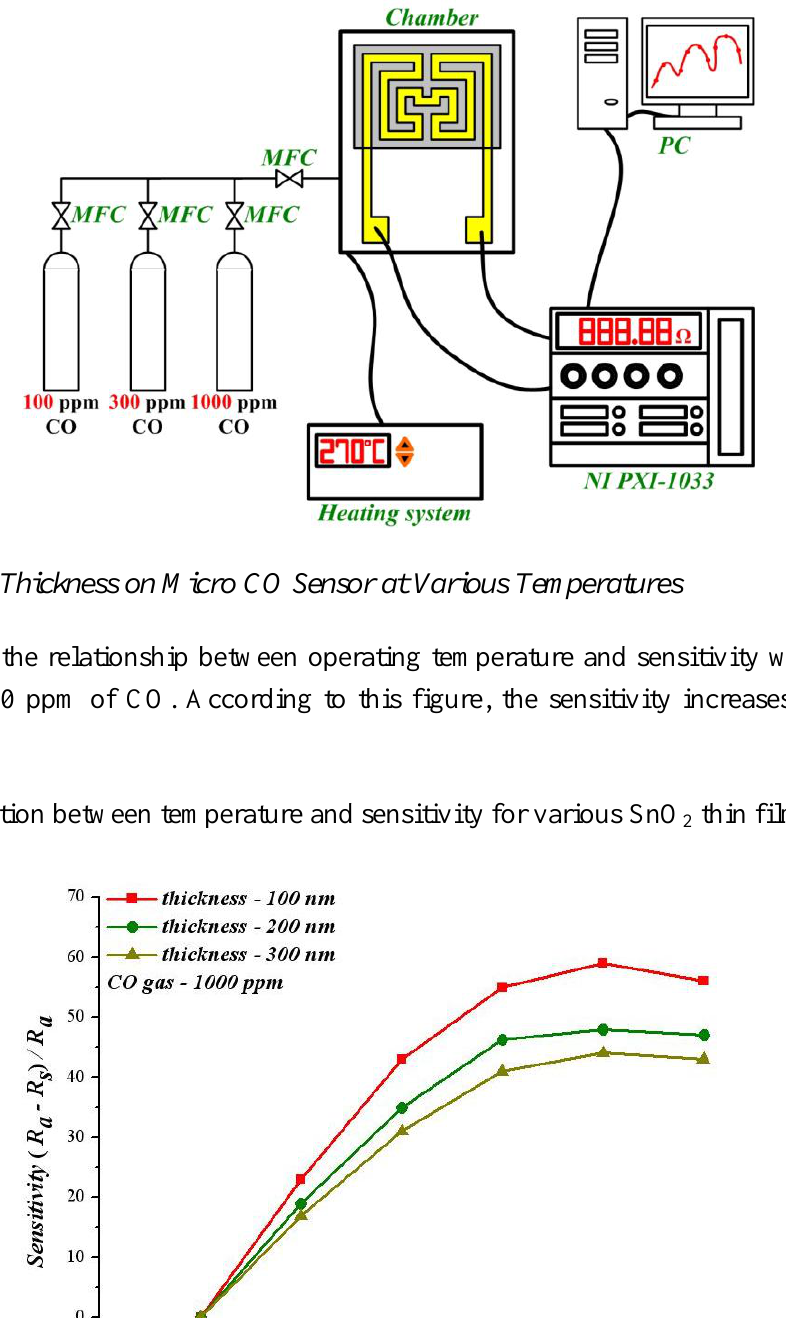
Figure 3. Calibration system of CO sensor.